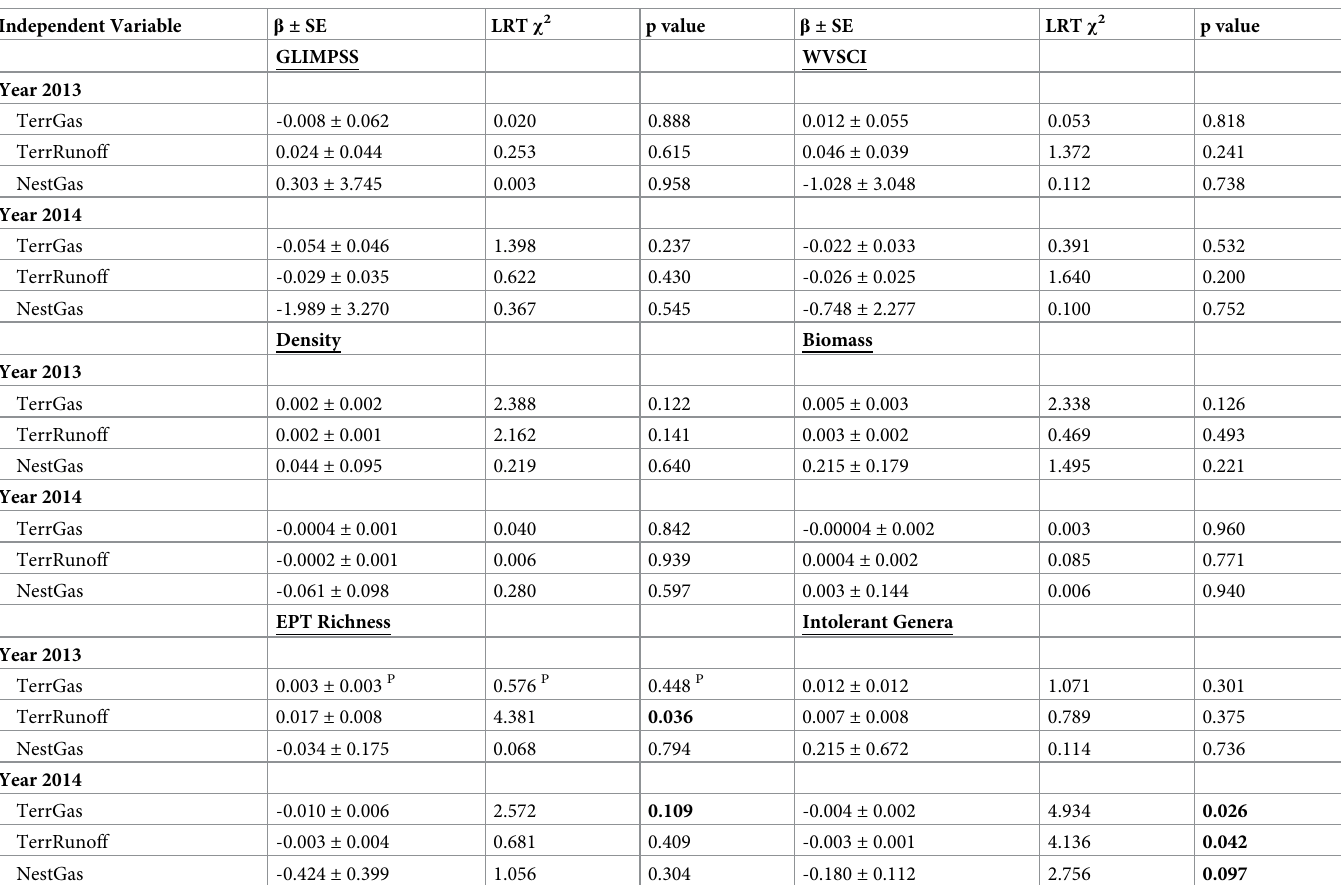
Table 3. Association between waterthrush aquatic prey and shale gas disturbance metrics in spatial generalized linear mixed models. Results with P are from a Pois- son model. In 2013, EPT richness increased with increasing TerrRunoff, but in 2014 EPT richness decreased with increasing TerrGas. In 2014, intolerant genera decreased with increasing TerrRunoff, TerrGas, and NestGas. P values of variables that are statistically significant are bolded. Variable names are defined in S2 Table. LRT = likelihood ratio test χ 2 statistic. β = beta estimate of fixed